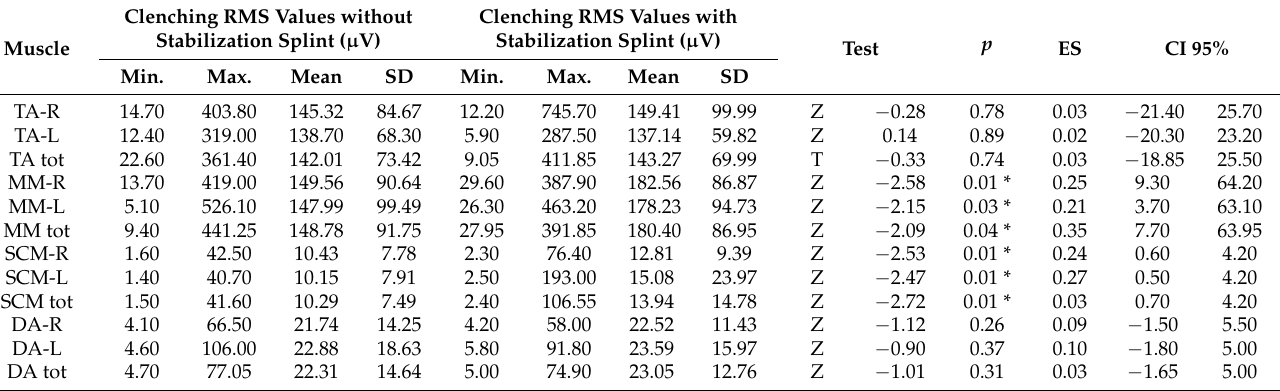
Table 3. Comparison of root mean square (RMS) functional bioelectric potentials during maximal tooth clenching with and without stabilization